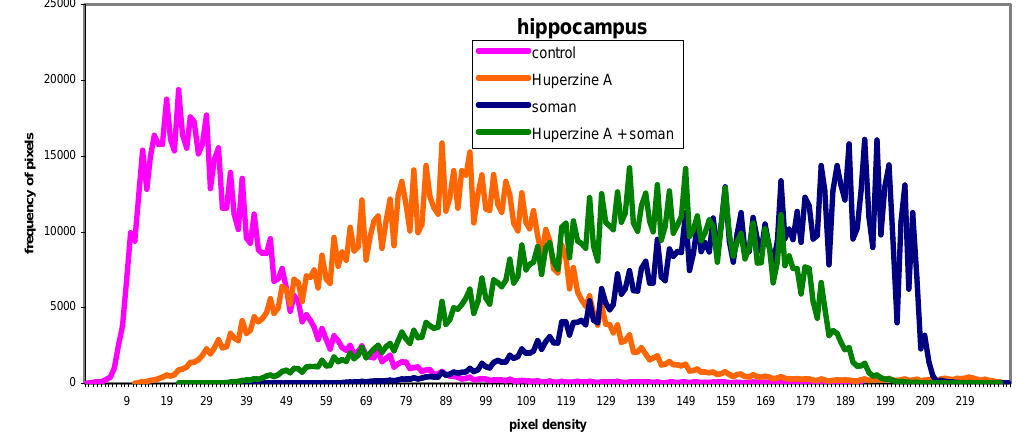
Bottom: Quantitative evaluation of histochemical data: Density curves of